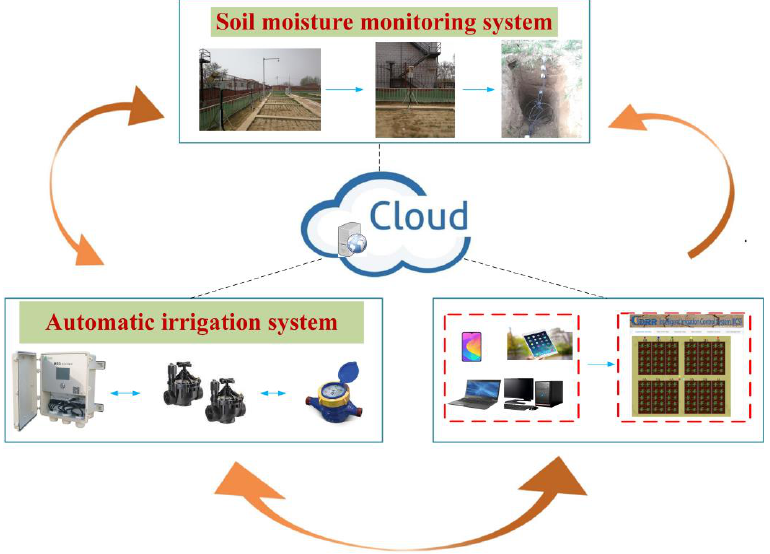
Figure 2. Design of intelligent irrigation control system (IICS). The IICS consists of a soil moisture monitoring system and an automatic irrigation